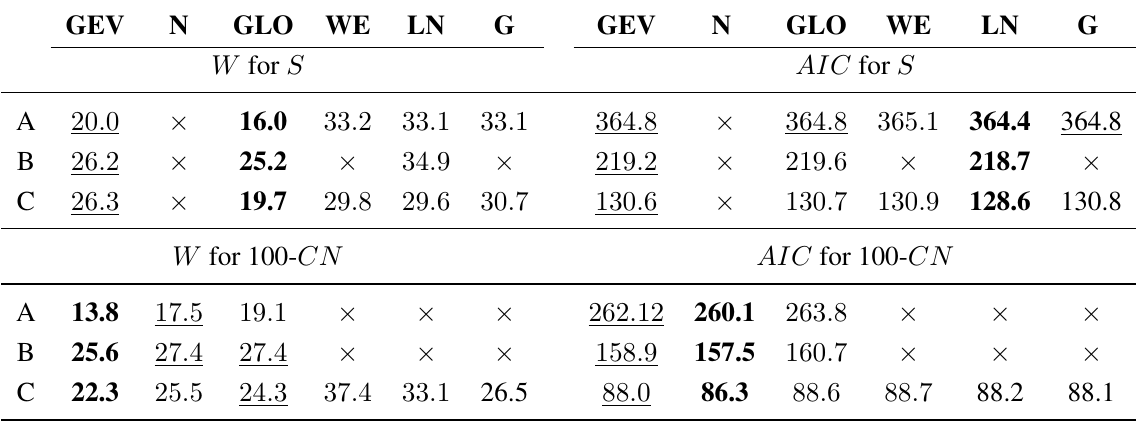
Table 2. The values of W and AIC applied to S and 100- CN (measure W was multiplied by 100). The best fit is bolded, the second is underlined and other fittings displayed in normal fonts. GEV, generalized extreme value; N, normal; GLO, generalized logistic; WE, Weibull; LN, lognormal; G,